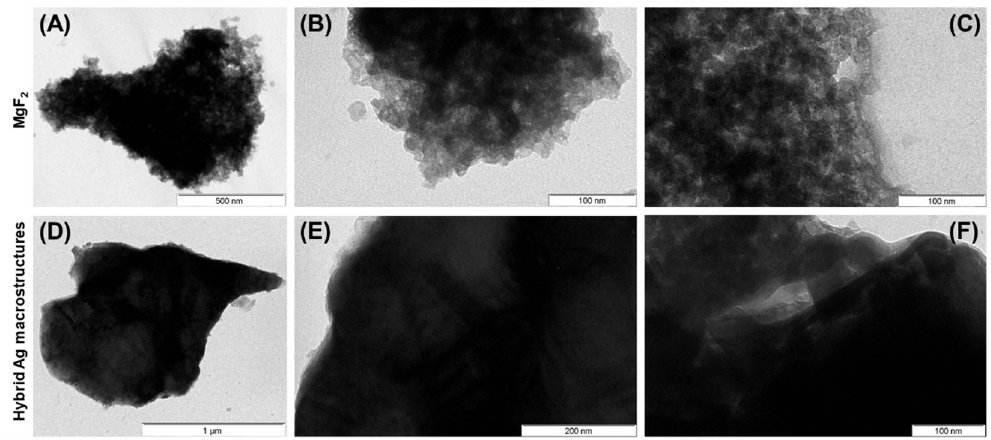
Figure 2. Representative transmission electron microscopy (TEM) images of ( A–C ) MgF 2 from AVe and ( D–F ) hybrid Ag microstructures from AVe.